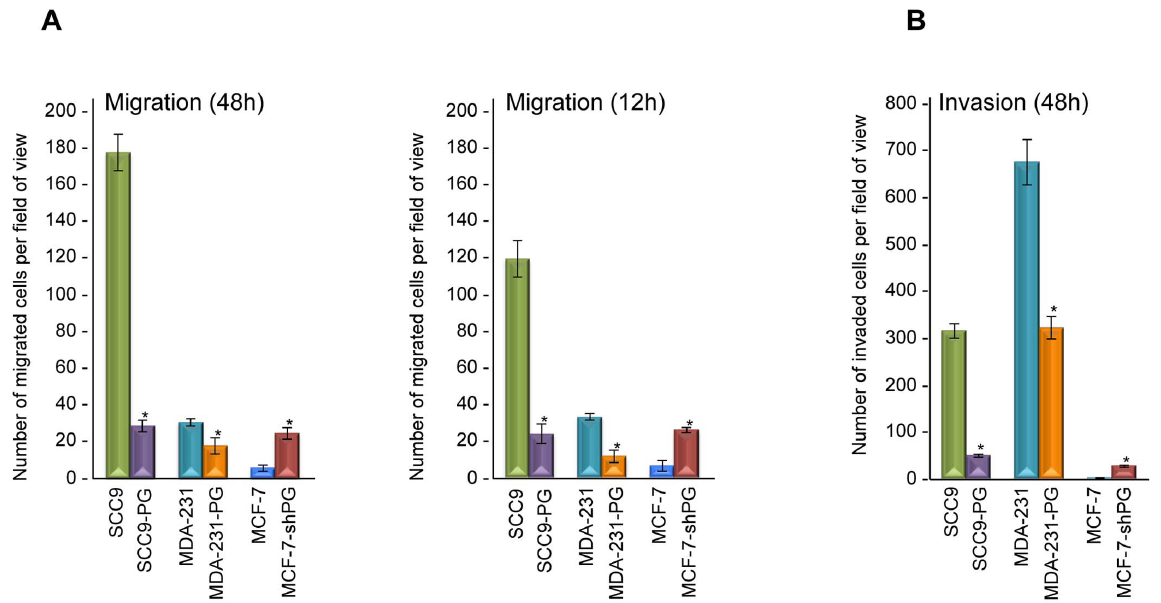
Figure 6. Plakoglobin decreases invitro migration and invasion. A. Forty-eight- and twelve-hour Transwell migration assays were performed in triplicates for SCC9, SCC9-PG, MDA-231, MDA-231-PG, MCF-7 and MCF-7-shPG cell lines. The membranes were fixed, stained, cut and mounted on slides and viewed under an inverted microscope. B. Forty-eight-hour matrigel invasion assays were performed as described in A using matrigel coated transwell membranes. The number of migrated/invaded cells in five random fields for each membrane were calculated using the ImageJ Cell Counter program and averaged. Histograms represent the average 6 SD of the number of migrated/invaded cells for each cell line. *p , 0.01). PG, plakoglobin.